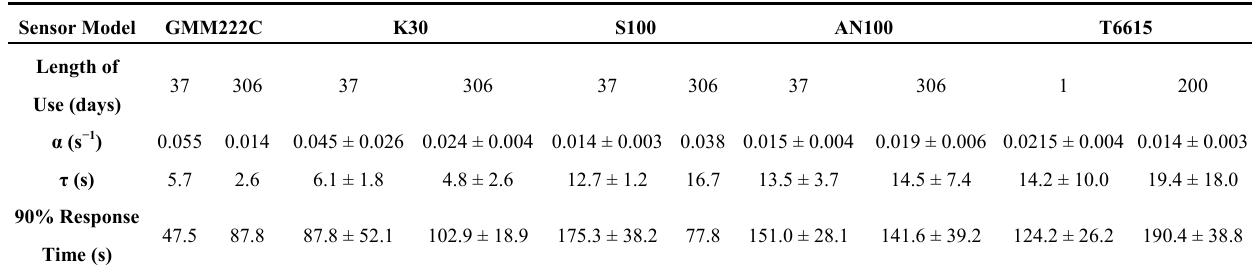
Table 3. Offset of time τ , time constant for the response to equilibrium α and 90% response time for sensors.